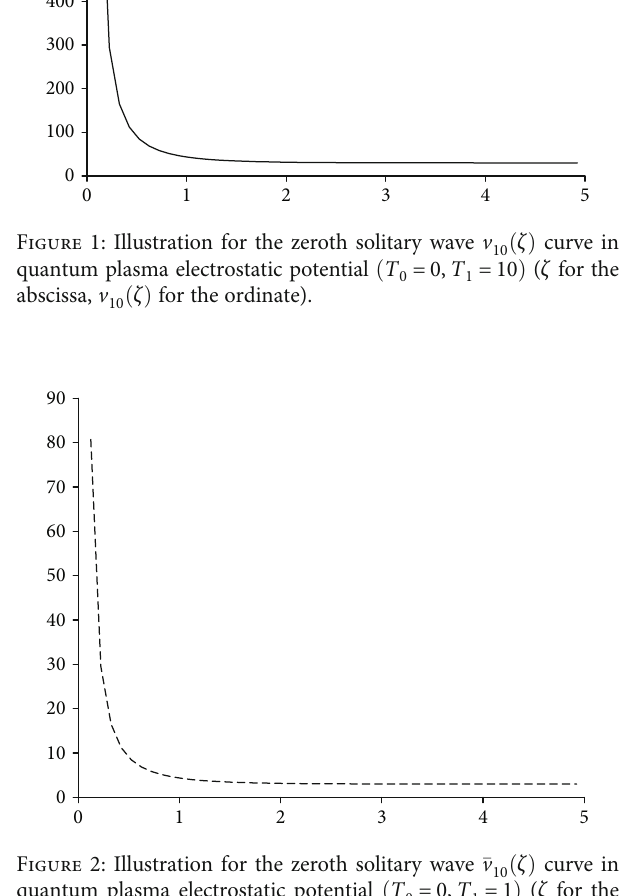
Figure 2: Illustration for the zeroth solitary wave (cid:1) v quantum plasma electrostatic potential ð T 0 = 0, T 1 = 1 Þ ( ζ for the abscissa, (cid:1) v 10 ð ζ Þ for the